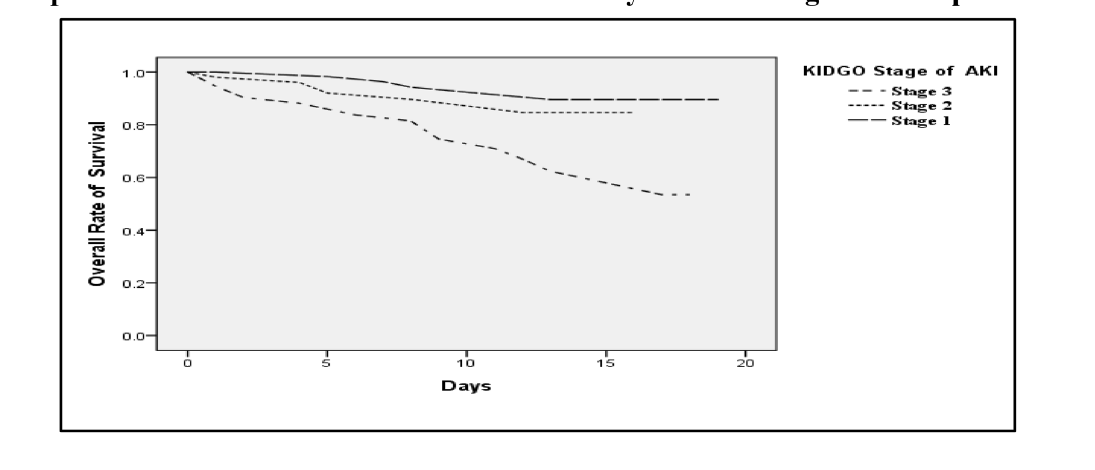
Figure 1. Kaplan–Meier analysis demonstrating survival probability in patients with stage 1, stage 2, and stage 3 AKI up to 20